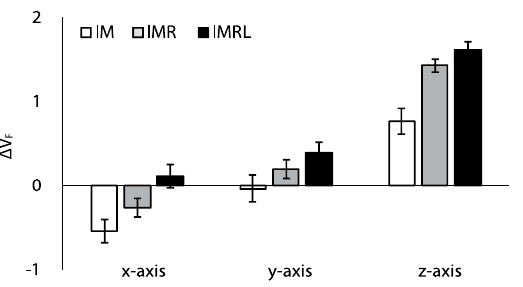
Figure 3. Z-transformed synergy indices with respect to F TOT stabilization, Δ V F , for the IM (white bars), IMR (gray bars), and IMRL conditions (black bars) at the x -, y -, and z -axis. Values are means ± standard errors across the